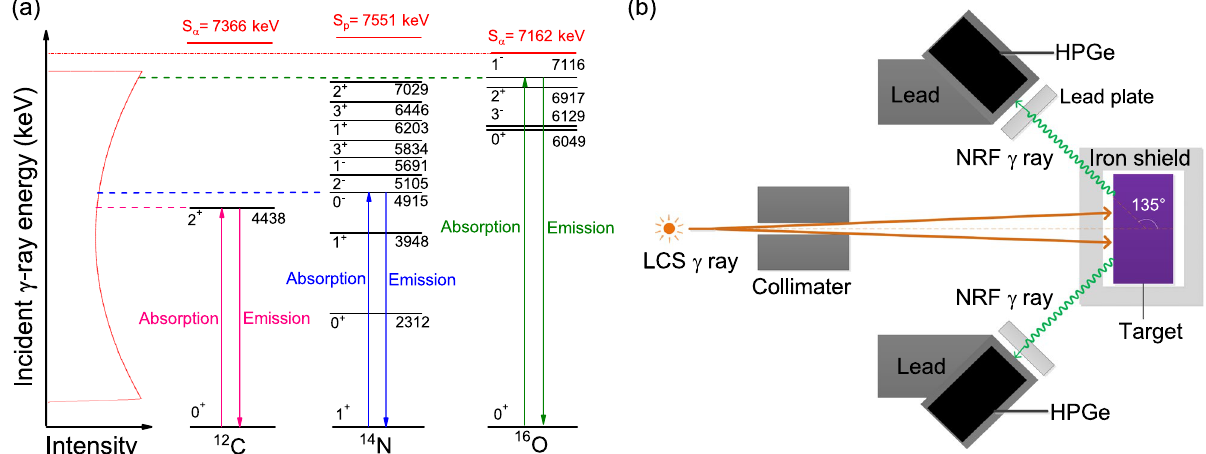
Figure 1. ( a ) Schematic view of nuclear excitation and de-excitation. If the energy of the γ -ray beam, which is produced by Compton backscattering of a laser pulse from high-energy electron beam, is identical with the excitation energy of the nucleus of interest, it can be effectively absorbed in the nucleus, which de-excites subsequently by emission of NRF photons. ( b ) Schematic view of the NRF-based inspection system using a LCS γ -ray source. After collimation, the LCS γ -ray beam penetrates through the iron shield and then impinges on the drug target, producing NRF γ rays. In order to realize backscatter NRF inspection, four high-purity germanium (HPGe) detectors are assembled on a detection plane with large angle of 135 ◦ with respect to the beam propagation. The lead plates are installed in front of HPGe detectors to improve the ability to operate detectors by reducing the intensity of the low-energy portion of the scattered